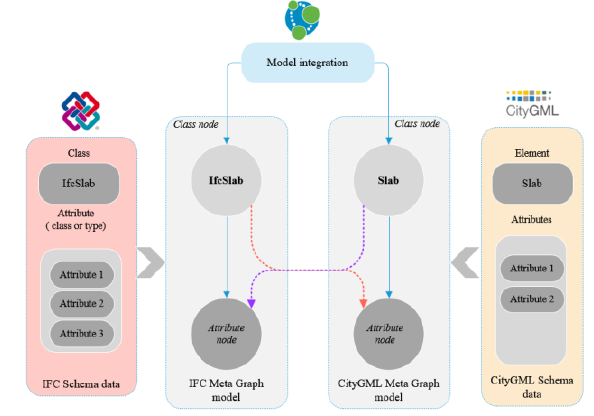
Figure 9. Enhanced attributes of BIM-GIS information using Graph